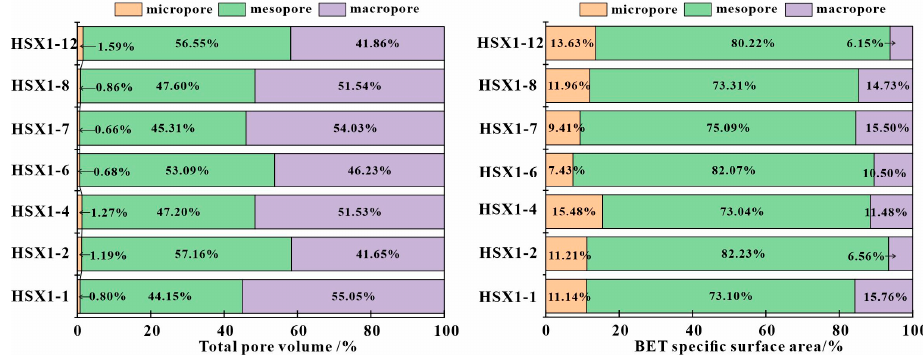
Figure 5. N 2 adsorption total pore volume and BET SSA of shales from Fengcheng Formation.